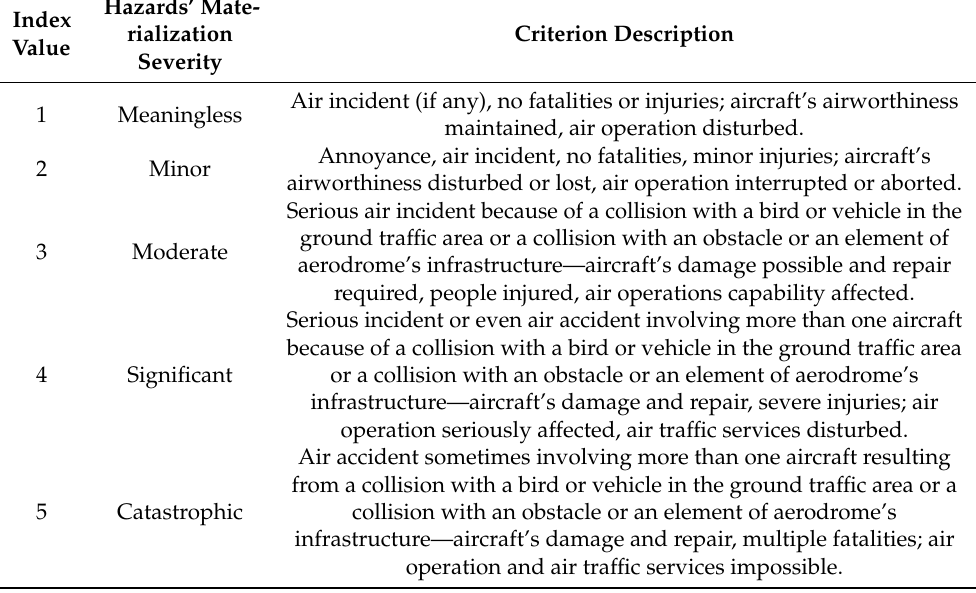
Table 2. Proposed classification table for risk severity index— S , own work based on [17,46,47].